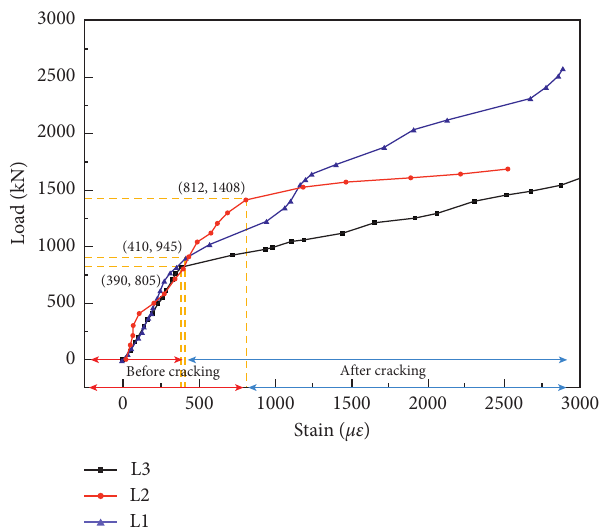
Figure 15: Load-wed tensile strain